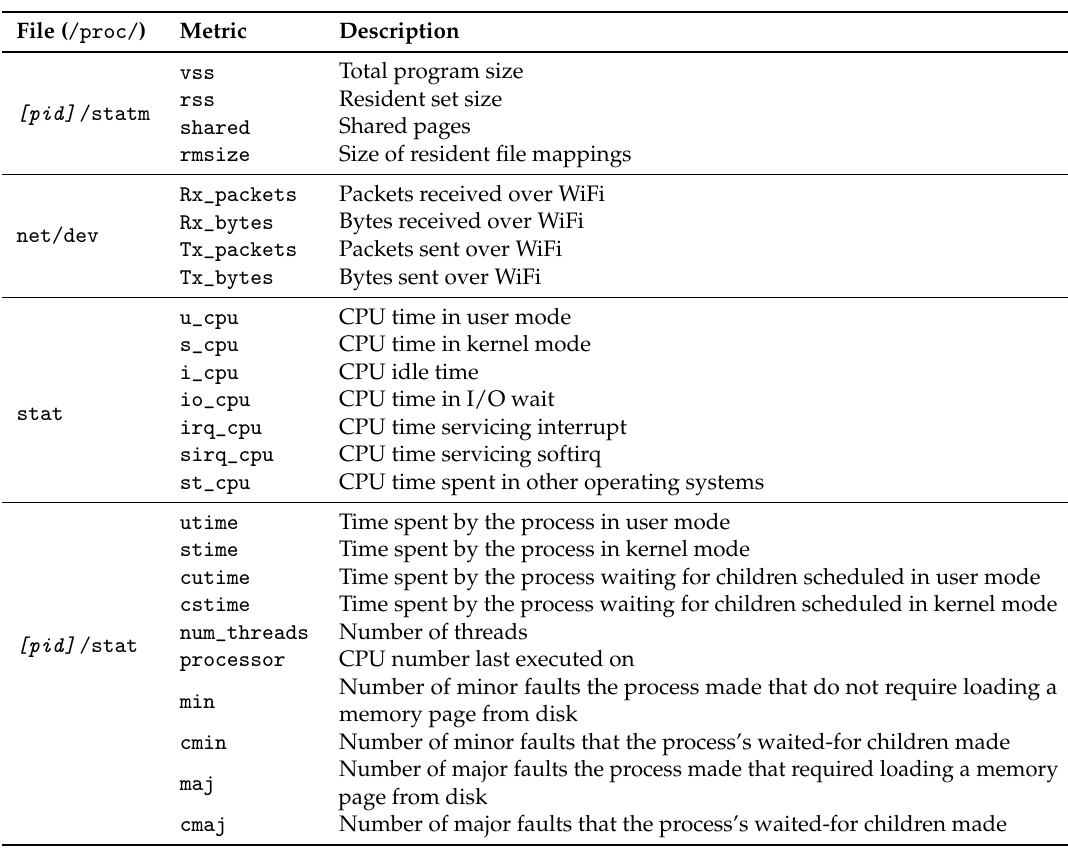
Table 1. Monitored metrics from the proc file